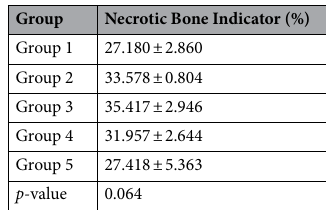
Table 7. Comparison of necrotic bone indicator percentage among the PO BRONJ model groups. The statistical analysis was performed using ANOVA. The data are depicted as the mean ± standard deviation.